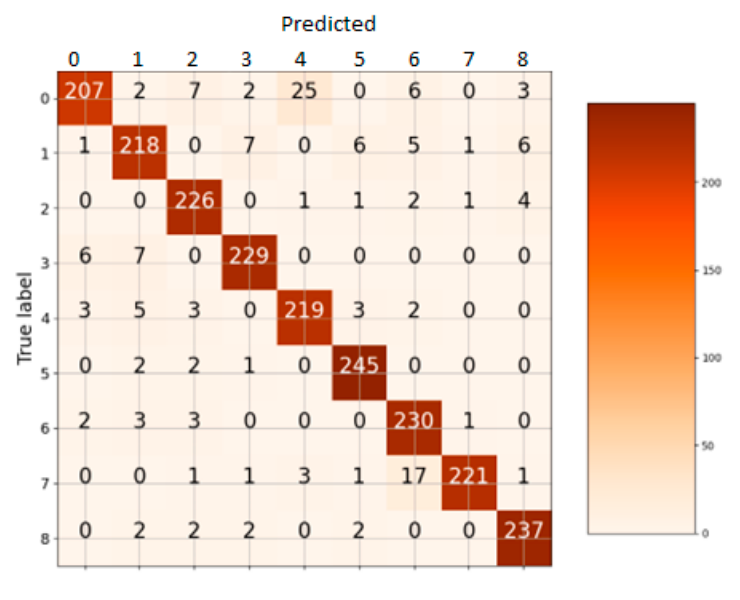
Information 2022 , 13 , x FOR PEER REVIEW